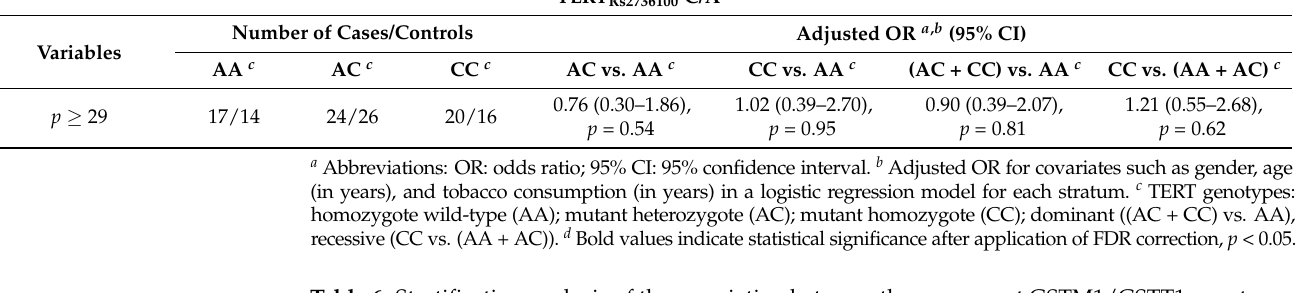
Table 6. Stratification analysis of the association between the concurrent GSTM1/GSTT1 genotypes and laryngeal